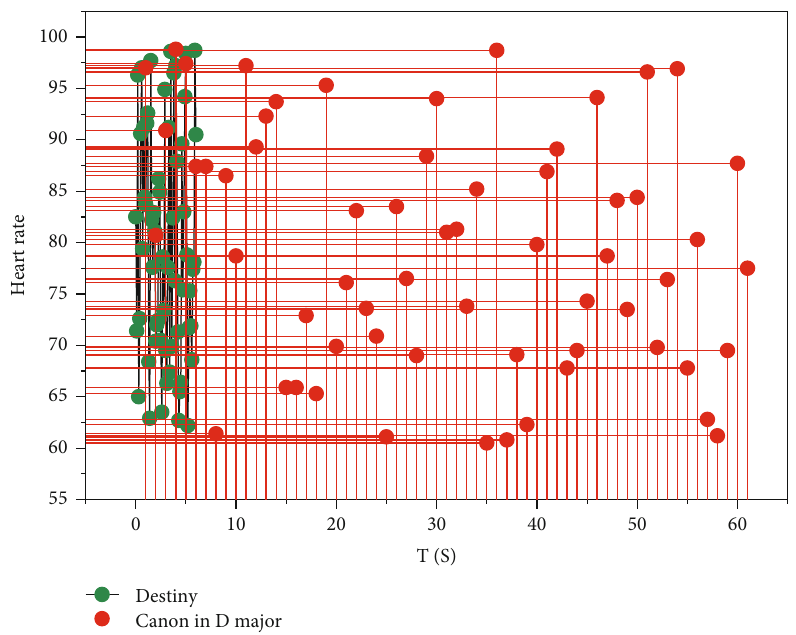
Figure 8: Heart rate variation under di ff erent piano repertoire.